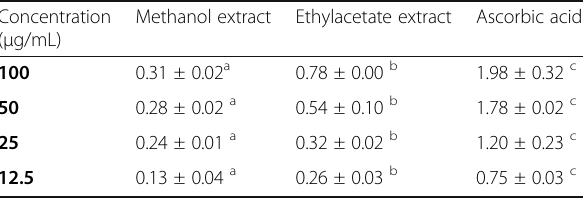
Table 3 Ferric Reducing Antioxidant Activity of Methanol